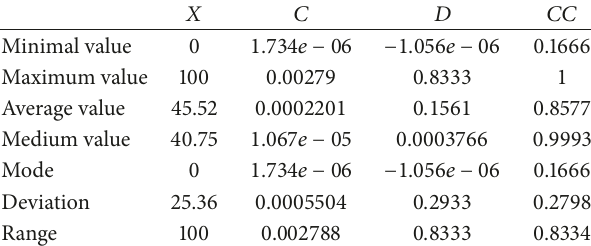
Table 10: The statistical analyses of strategies 𝐶 , 𝐷 , and 𝐶𝐶 .